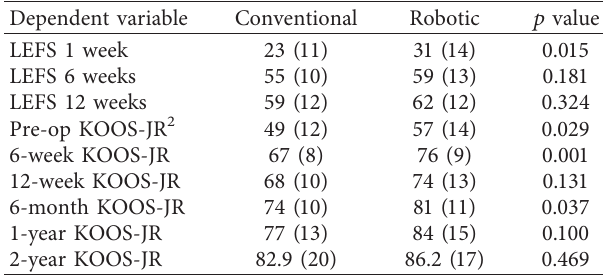
Table 2: A summary of functional